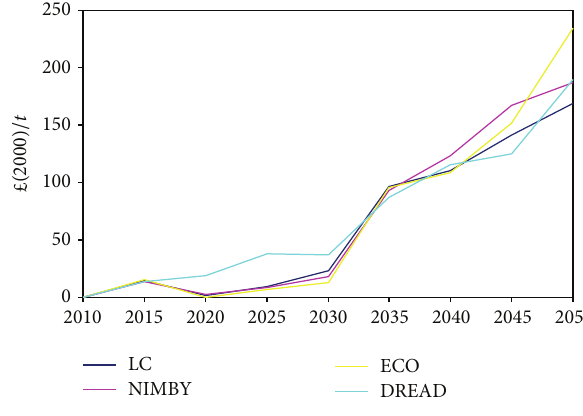
Figure 6: Marginal cost of CO 2